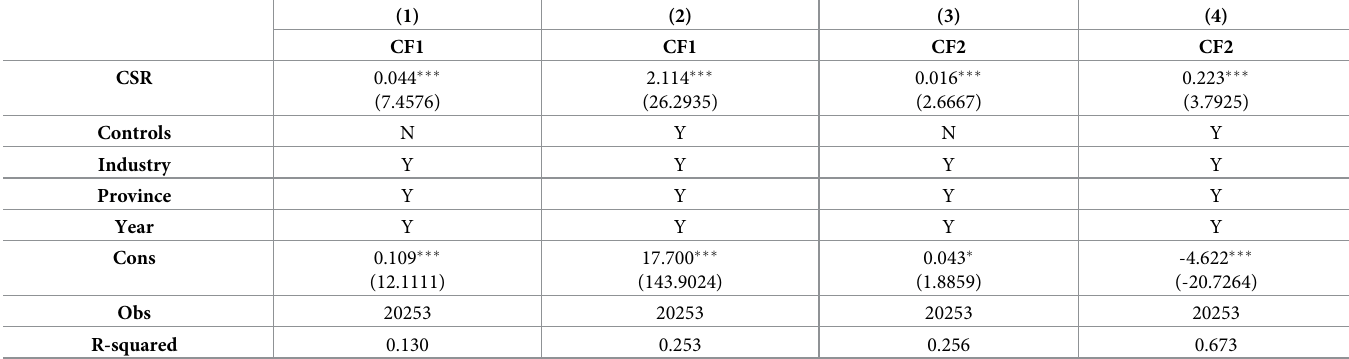
Table 9. Robustness test: FA lags one-stage regression.